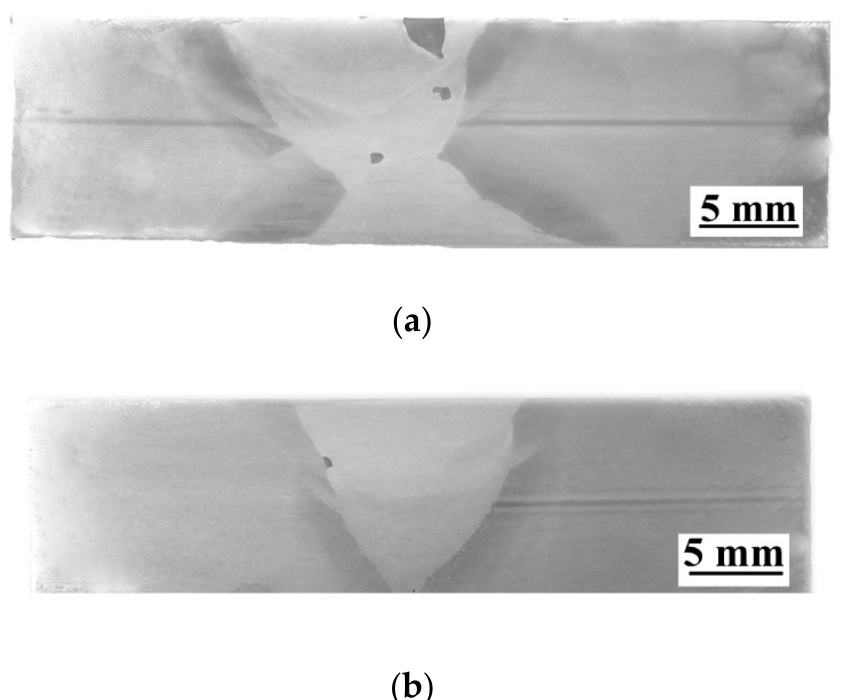
Figure 9. Results of macroscopic testing: ( a ) s pecimen SW and ( b ) s pecimen SA.